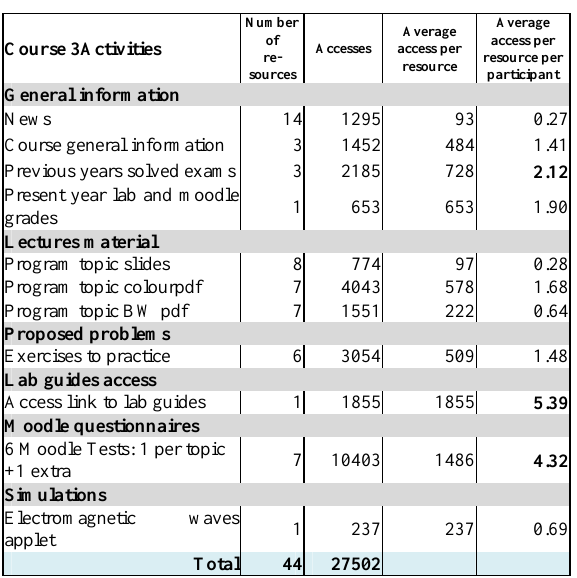
TABLE V. M OODLE C OURSE 3 ACESSES PER RESOURCE AND PARTICIPANT